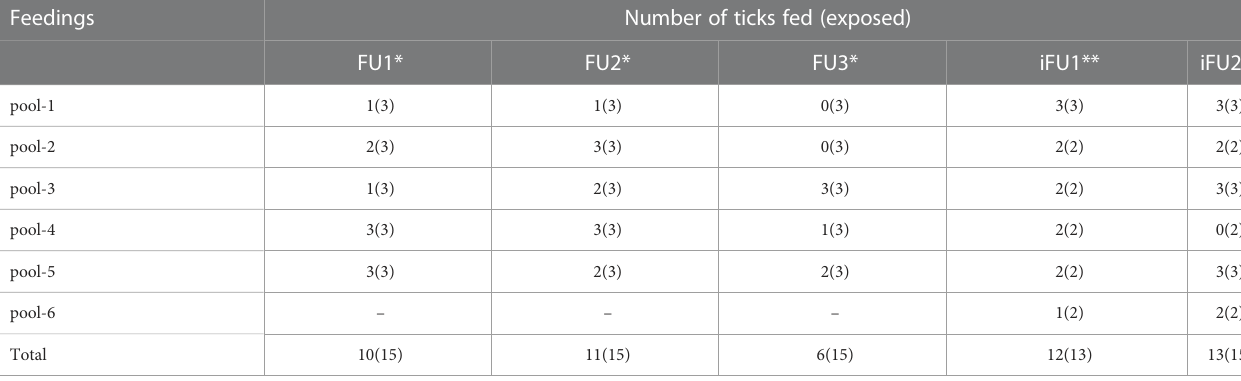
TABLE 1 Feeding response of O. moubata nymphs to GSH solution. Feedings Number of ticks fed